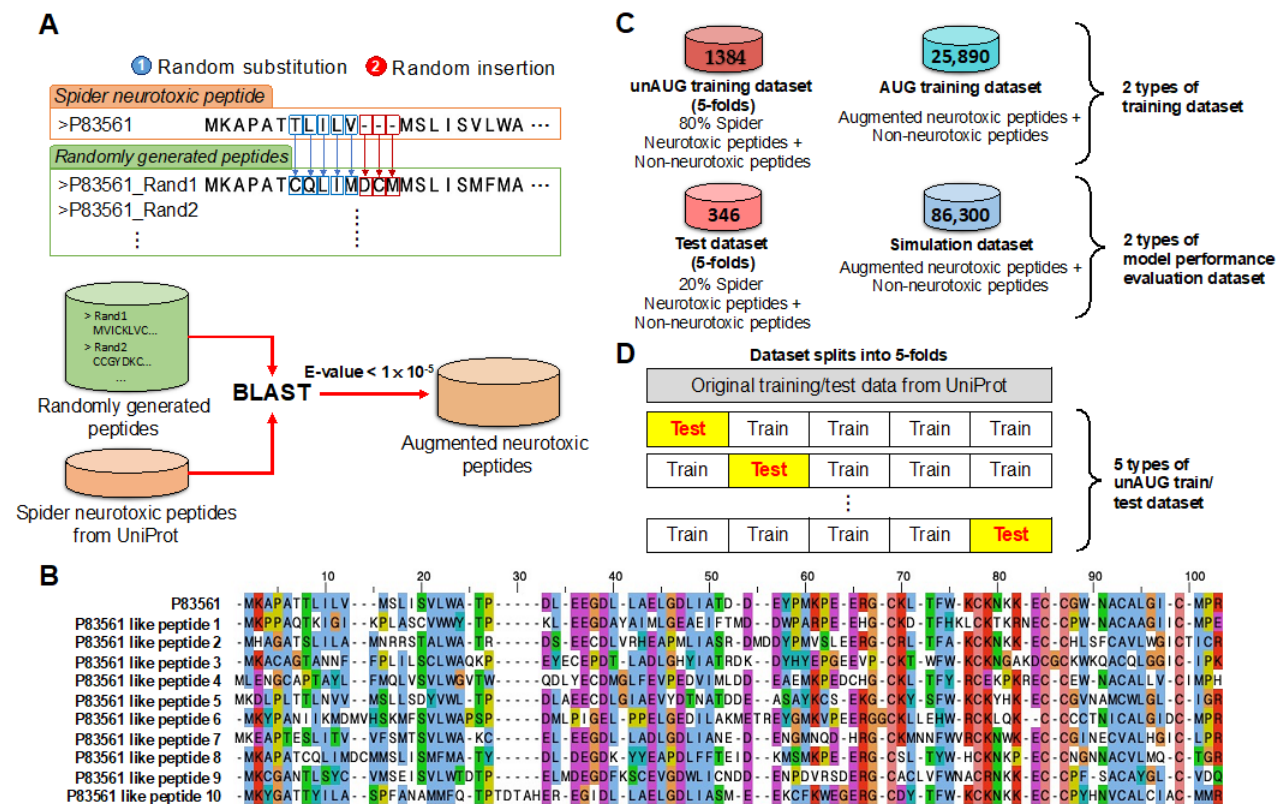
Figure 1. Data preparation overview. ( A ) Neurotoxic peptide data were augmented by using known peptides. The sequences were generated by random substitution and insertion of amino acids, and peptides under the E -value of 1 × 10 − 5 were selected by BLAST. ( B ) An example of a known neurotoxic peptide (P83561) and the derived AUG peptides. ( C ) Four types of datasets, two for training, and two for performance testing were prepared to evaluate the validity of the AUG neurotoxic peptides. ( D ) unAUG training and test data included neurotoxic and non-neurotoxic peptides from the UniProt. The data were split into 5-fold, of which one fold was selected for the test, and the others for model training.